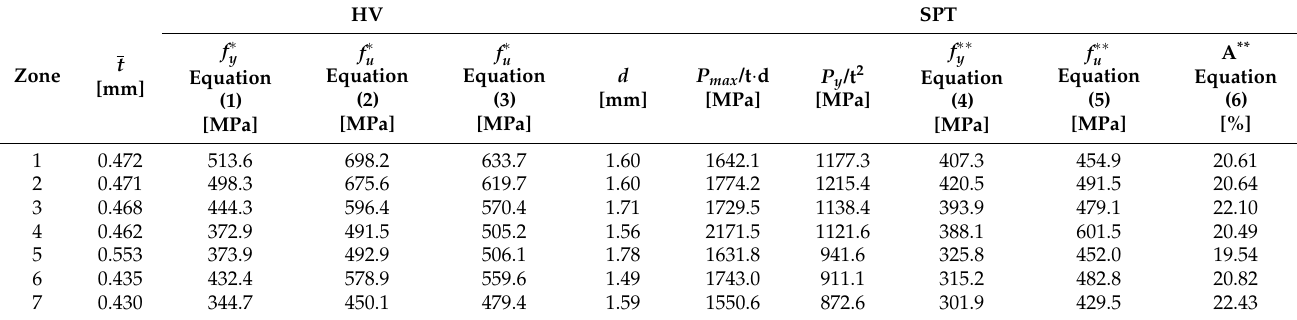
Table 7. Thickness, SPT results, and estimated properties through HV (*) and SPT (**) of the T8 M20 4.8 specimen.